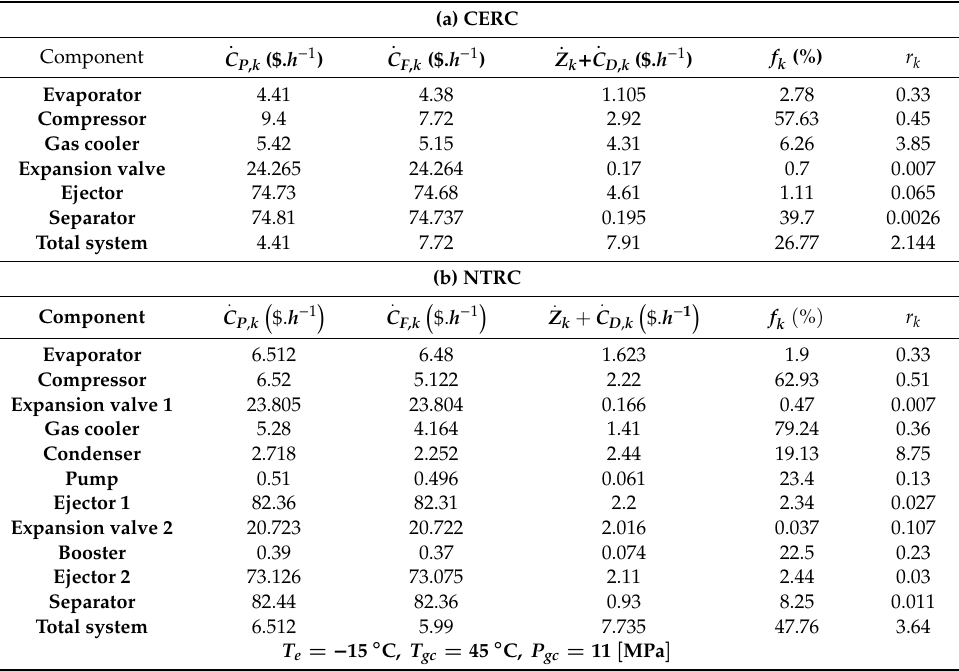
Table 10. CERC and NTRC components’ exergoeconomic parameters.